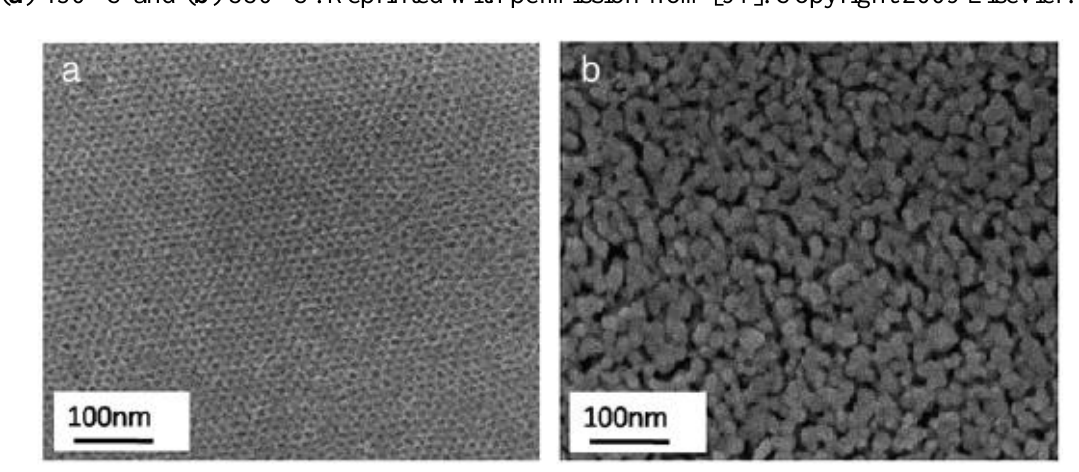
Figure 17. Depiction of mesoporous TiO films calcined at two different temperatures: 2 ( a ) 430 °C and ( b ) 550 °C. Reprinted with permission from [91]. Copyright 2009